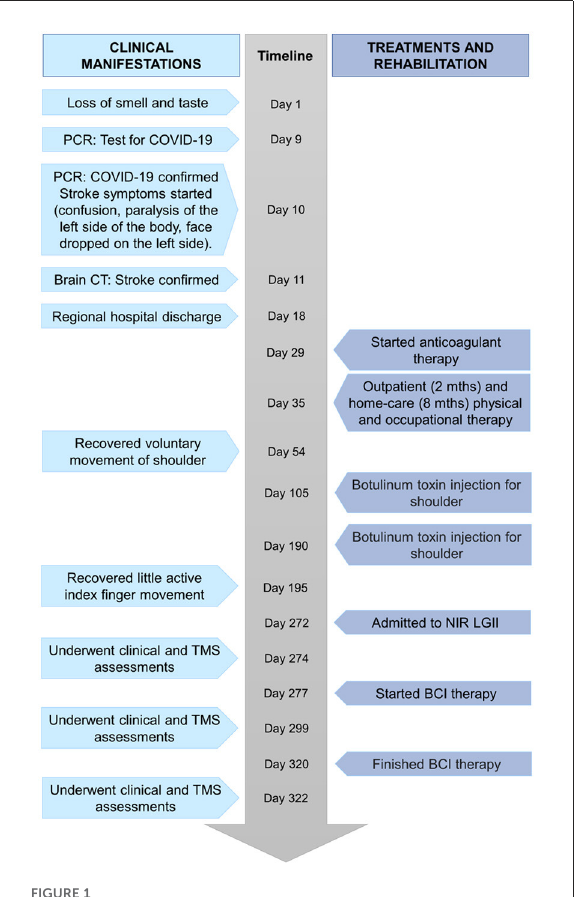
FIGURE1 Timeline with relevant clinical